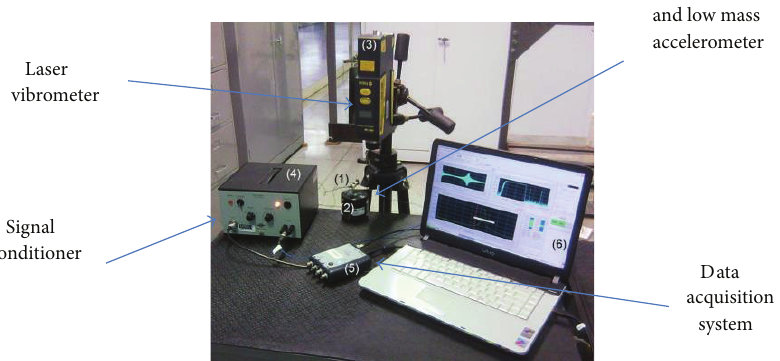
Figure 3: Experimental setup used for the verification of relations for a tapered beam.